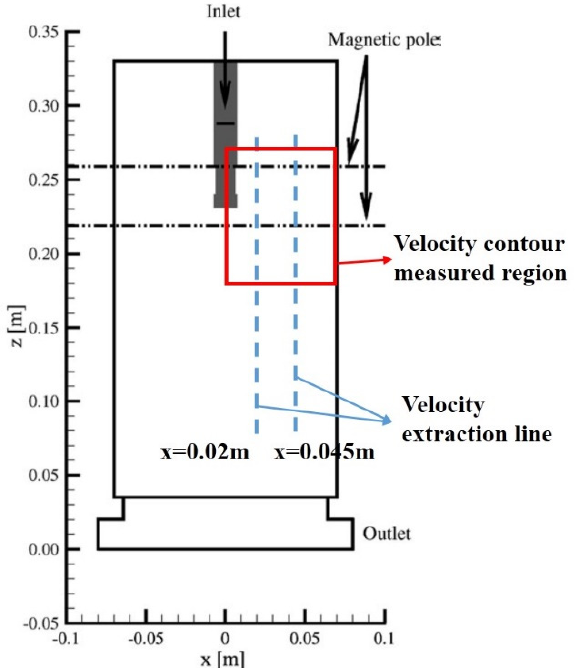
Figure 10. The computational domain of the continuous casting mold and the measured region and data extraction line (figure adapted from [264]).